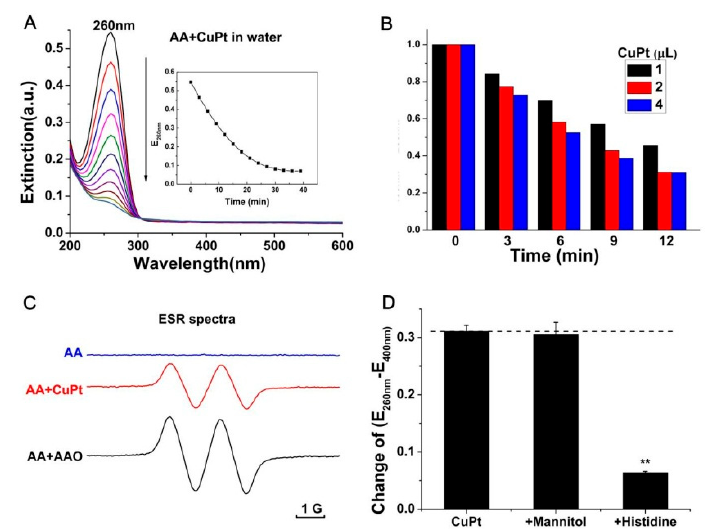
Figure 4. Antioxidant assay of AA. ( A ) UV-Vis-NIR spectra of AA after incubation with 1 μ L CuPt for every 3 min. Insert was the change of extinction at 260 nm with time. ( B ) The extinction changed with different concentrations of AA. ( C ) Electron spin resonance (ESR) spectrum of the ascorbyl radical. [AA] = 50 μ g/mL, [AAO] = 0.2 U/mL, and the volume of CuPt was 0.005 μ L. ( D ) The inhibitory effect on the oxidation of AA by incubating with mannitol and histidine for 2 min. The concentrations were [AA] = 57 μ M, [mannitol] = 5.50 mM, and [histidine] = 6.40 mM, and CuPt = 4 μ L.